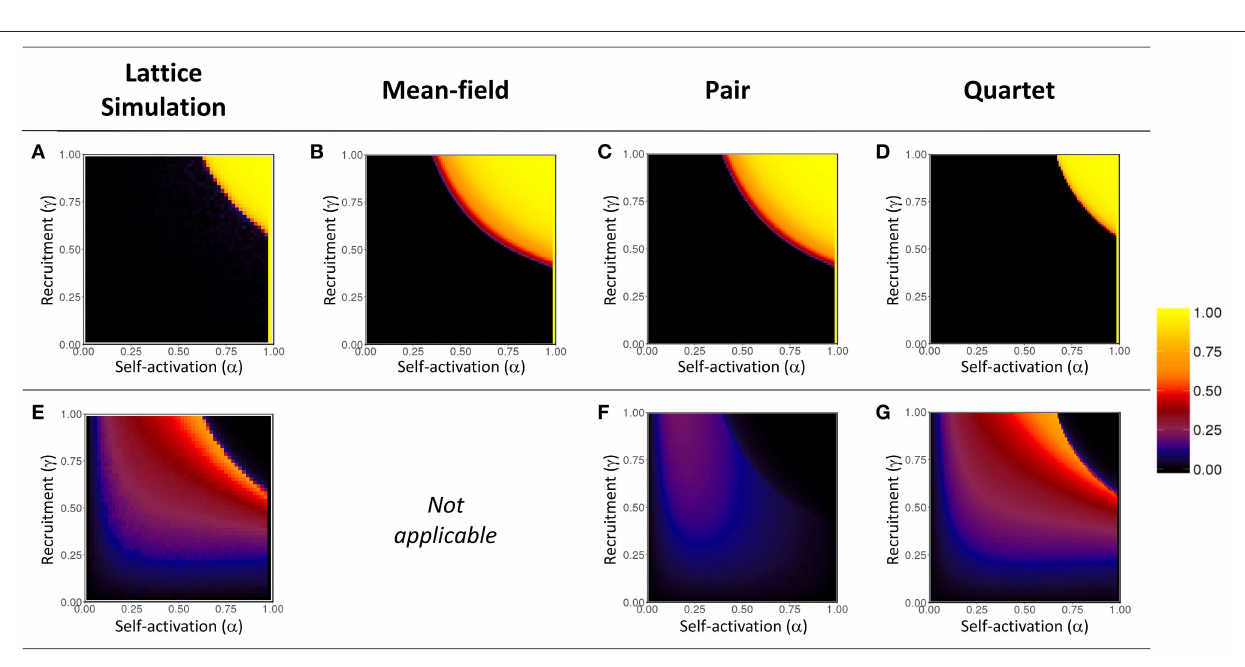
FIGURE 10 | Heatmap visualization of amplitude coefficient A (top row, A–D ), and clustering coefficient Q (bottom row, E–G ), in α - γ parameter space. Values measured at the end of 500,000 steps, for numerical simulations and for mean-field, pair, and quartet approximations. The narrow vertical band of maximum amplitude ( A ≈ 1) is the trivial case at α = 1 wherein the entire lattice oscillates in unison. The clustering coefficient cannot be calculated for the mean-field approximation. The color scale applies to both A and Q ; rare negative values of Q were very near zero and are represented as such in the